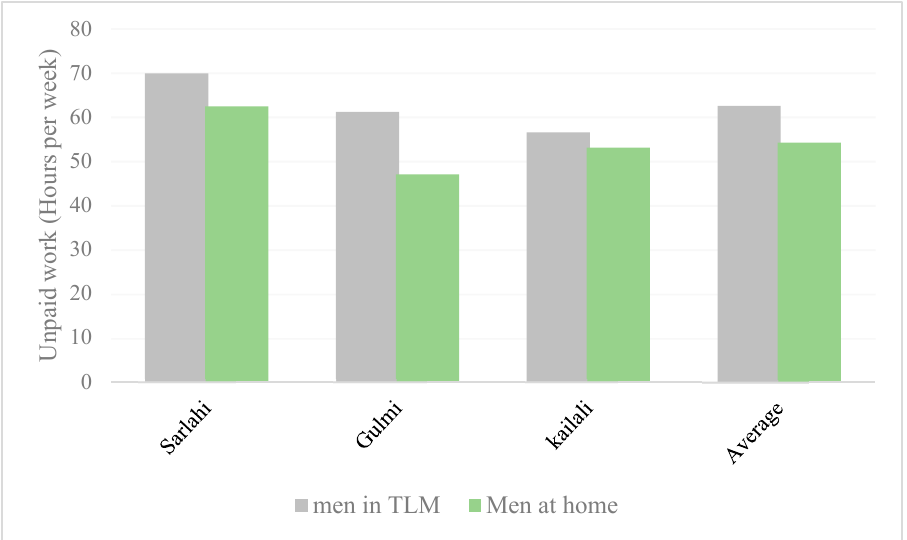
Figure 6. Migration status of husband and Unpaid domestic workload (hours per week) on wife.